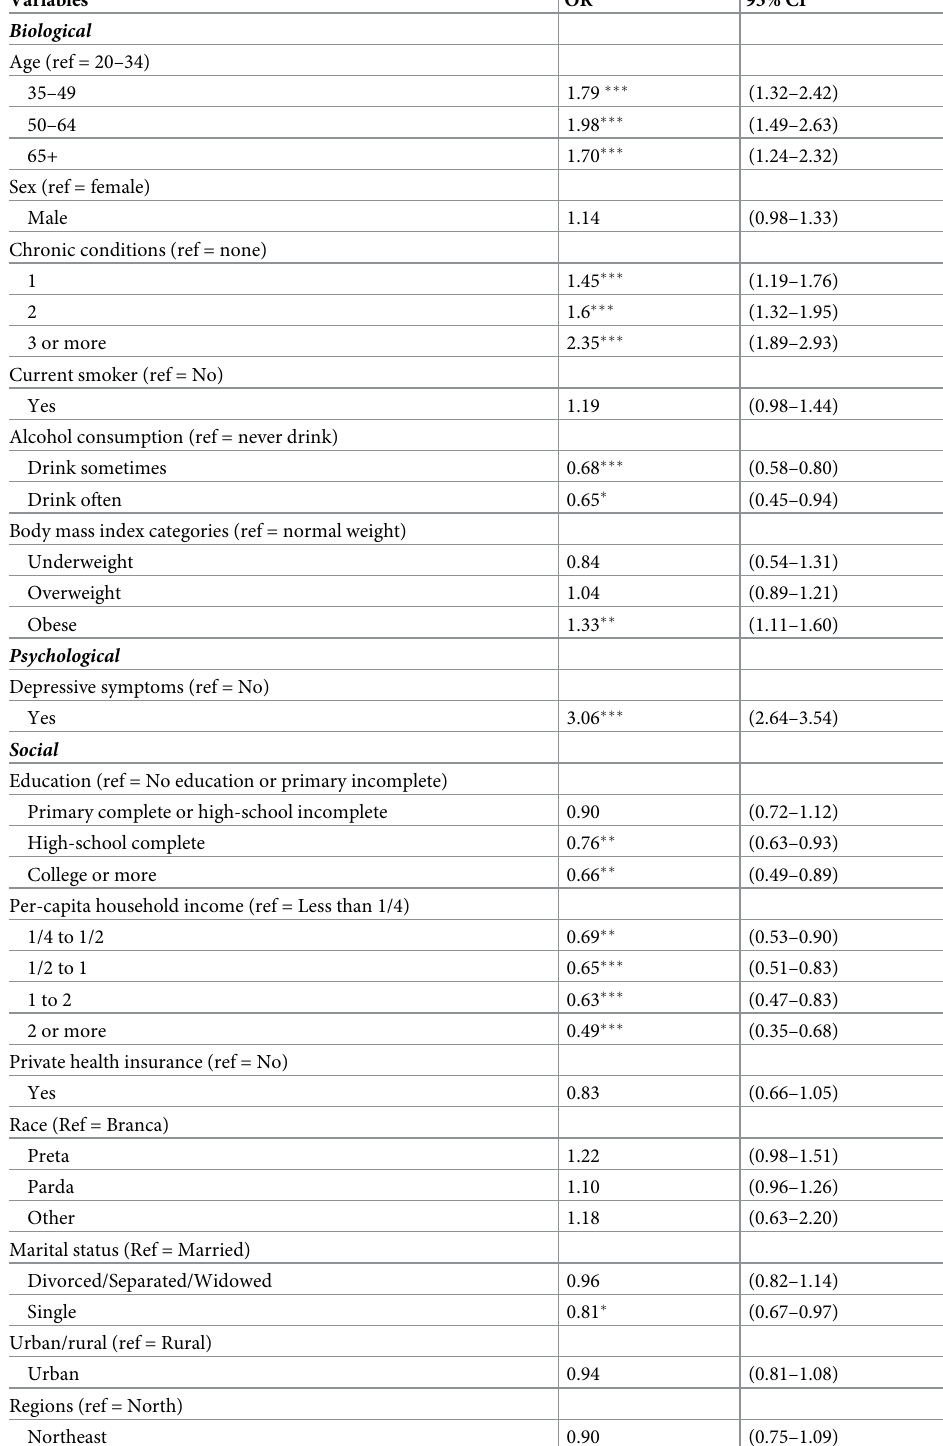
Table 4. Adjusted odds-ratios and 95% confidence intervals of having intense limitations on usual activities due to chronic back pain and biopsychosocial